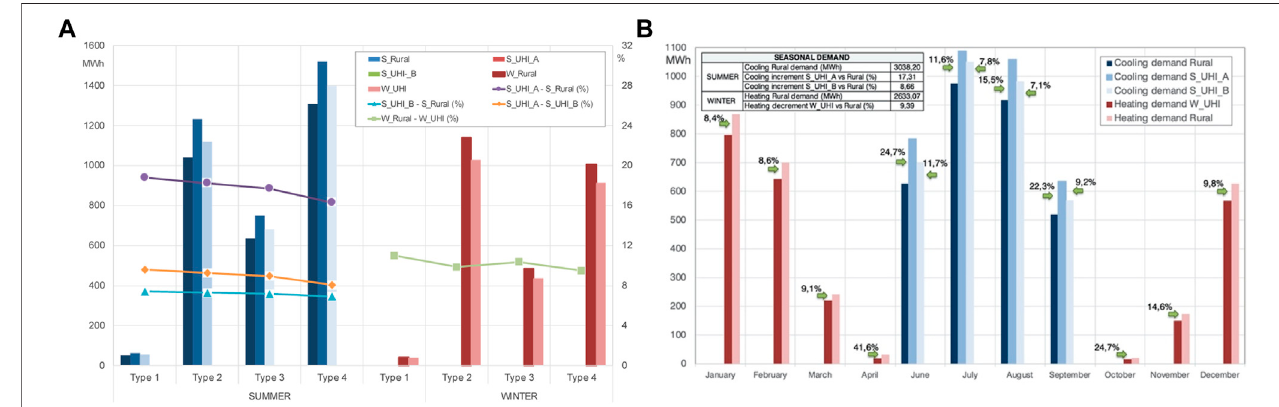
FIGURE 11 | SSeasonal heating or cooling demand of all buildings of each type calculated by rural or urban weather and corresponding percent differences (A) , total monthly and seasonal demand in rural weather, and corresponding changes in urban weather (B) .